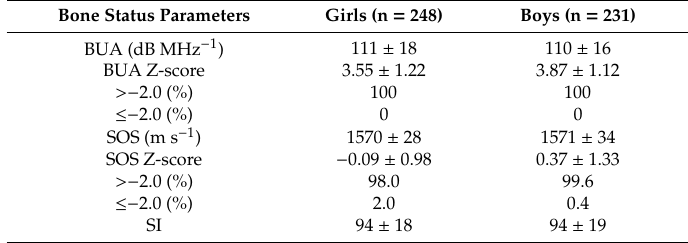
Table 4. Bone status of the study volunteers. Data are presented as Mean ±